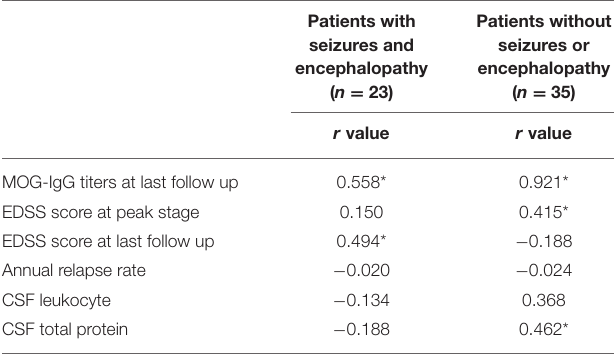
Patients with seizures and